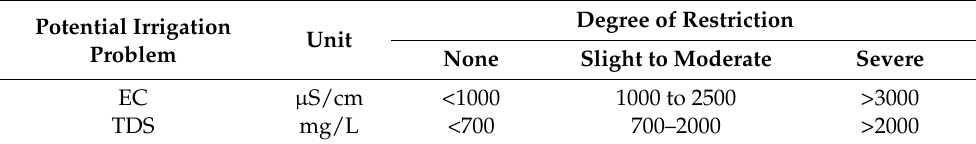
Table 4. Deduced from guidelines for interpretation of water quality for irrigation, modified from [54,55].